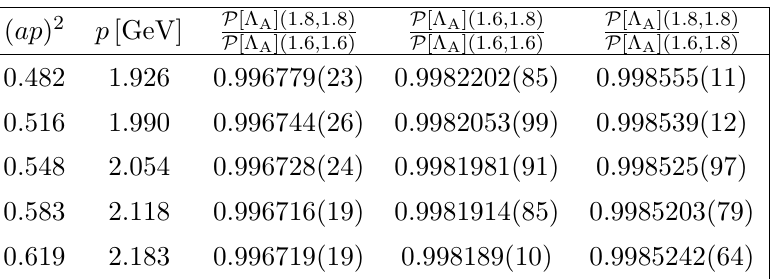
Table 7 . The ratios of projected amputated vertex function for the axial currents with di(cid:11)erent actions on the F1 ensemble. The quark mass for both (cid:12)elds is taken to be am l = 0 :